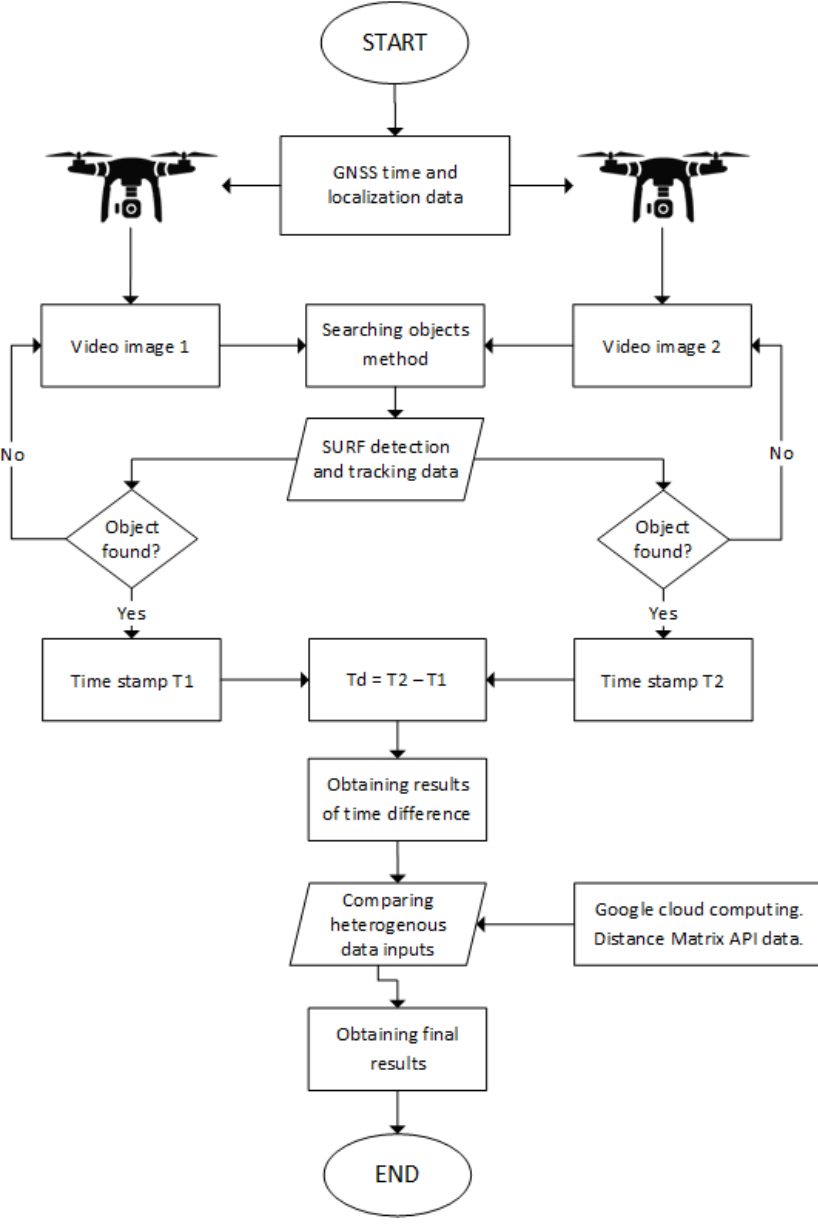
Figure 4. Algorithm for comparing vehicle travel time results obtained from UAV with data from the Google Distance Matrix API application. Source: our own study.